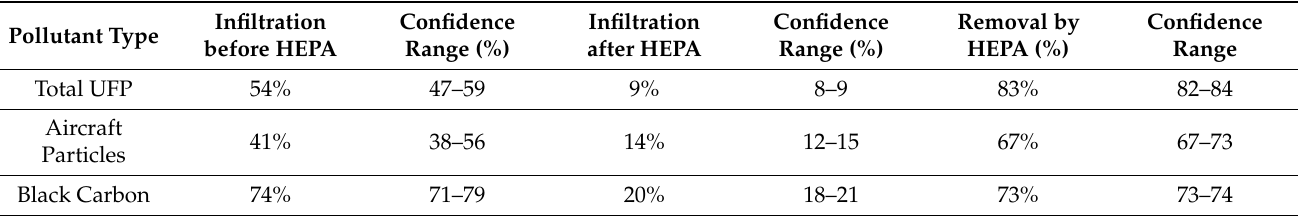
Table 6. Infiltration (%) with and without the portable HEPA filter unit.